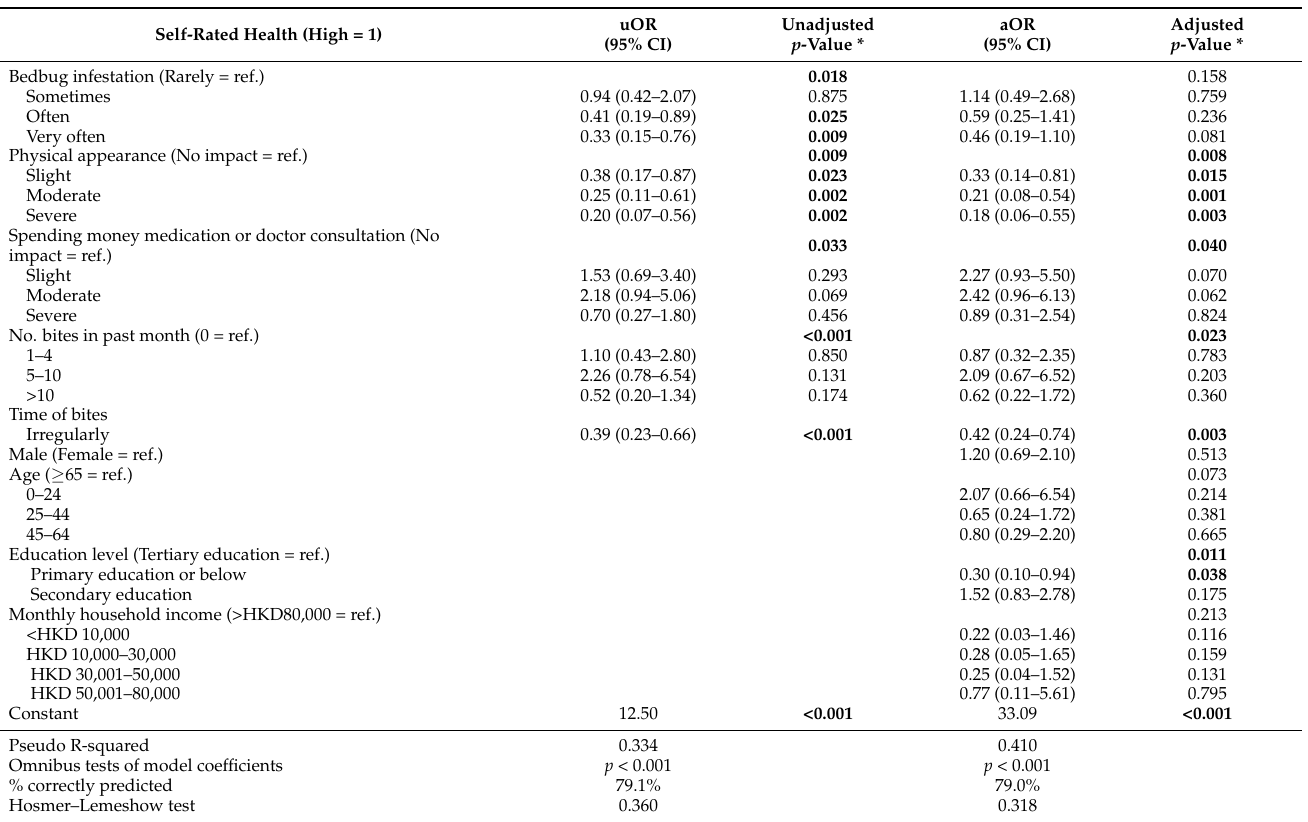
Table 3. Unadjusted and adjusted logistic regression for dichotomised self-rated health regressed against fitted variables. Self-Rated Health (High = 1) uOR (95% CI) Unadjusted p -Value * aOR (95% CI) Adjusted p -Value * Bedbug infestation (Rarely =